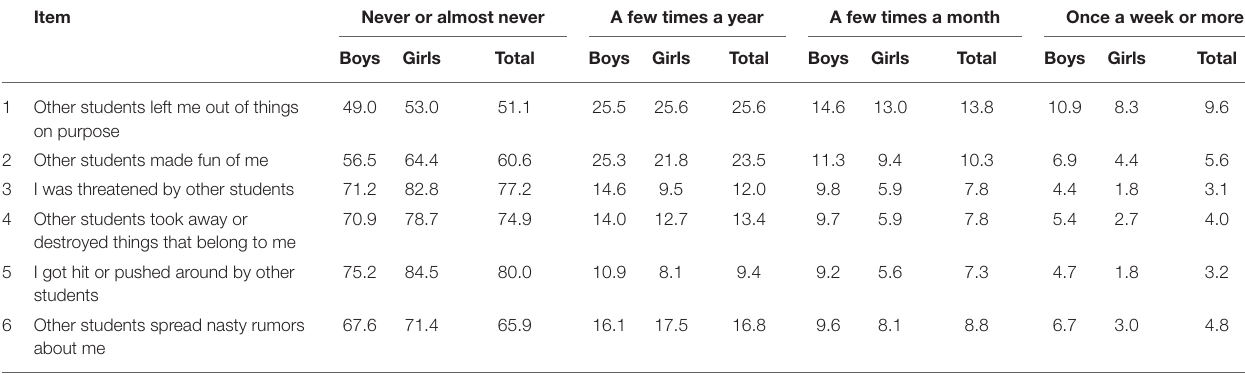
TABLE 1 | Prevalence (%) of bullying types, broken down by sex. Item